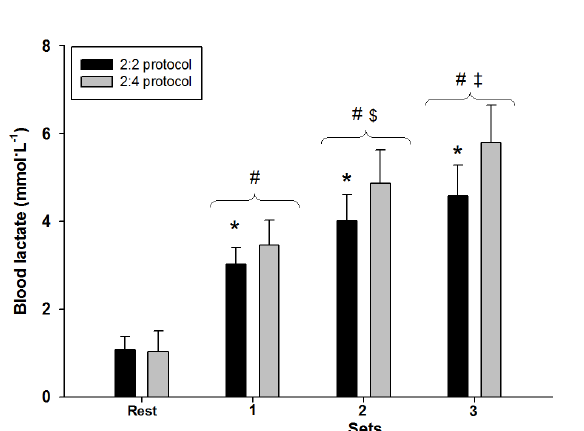
Figure 3. – Blood lactate concentration at rest and after each set